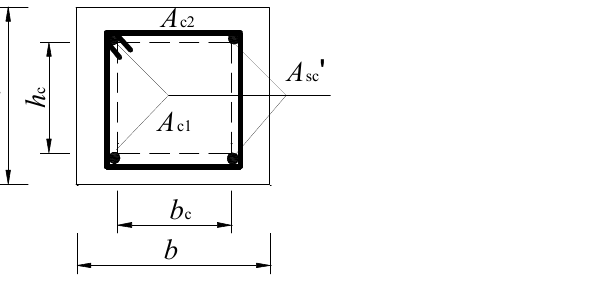
Figure 12. Division of bearing capacity in the cross-sectional area of stirrup-restrained concrete columns.